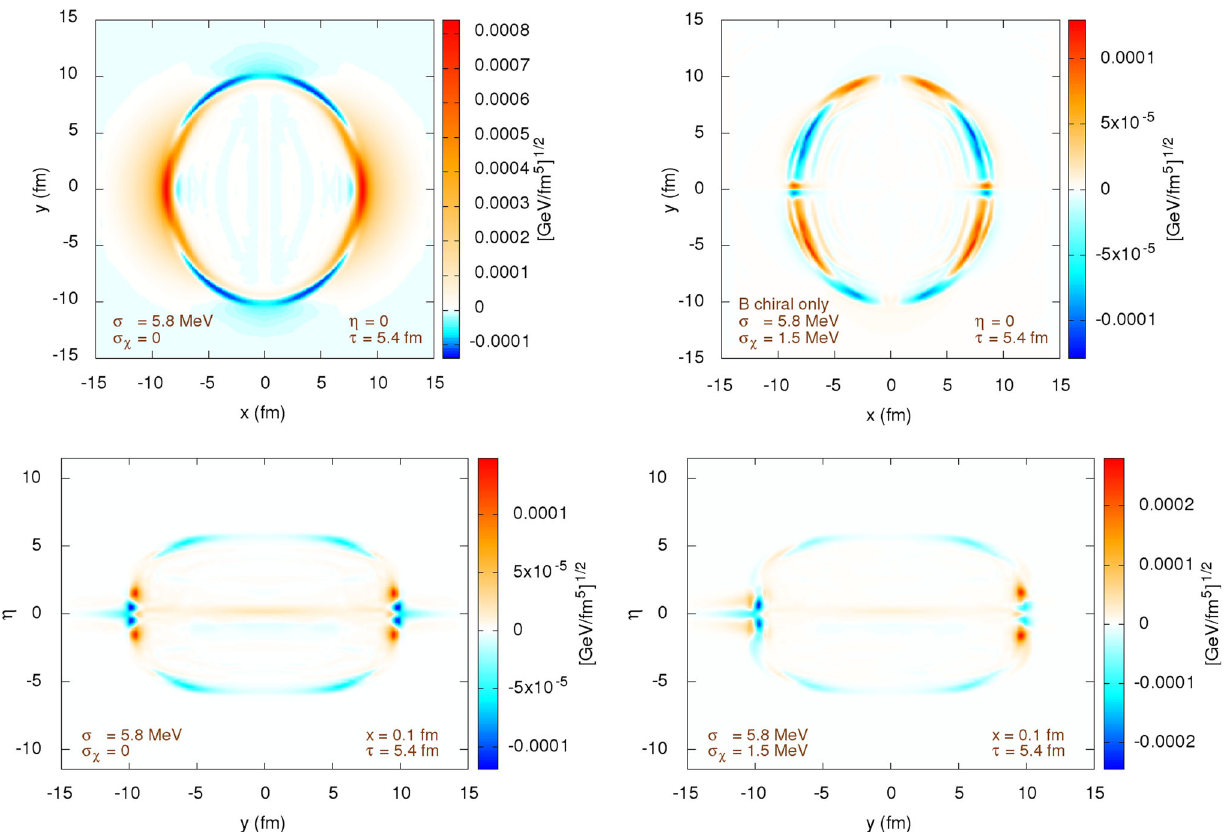
Fig. 9 Electric charge density distribution in the fluid comoving frame at τ = 5 . 4fm. Top left: Magnetic field of classical origin in transverse plane at mid-rapidity. Top right: Magnetic field of chiral origin only in transverse plane at mid-rapidity. Bottom left: Magnetic field of classical